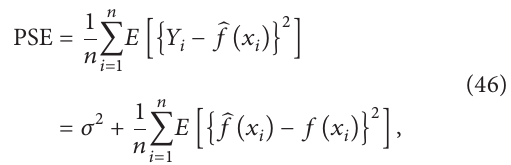
Table 6: Results of sample PSE of the penalized spline estimator. All entries for PSE are 10 2 times their actual